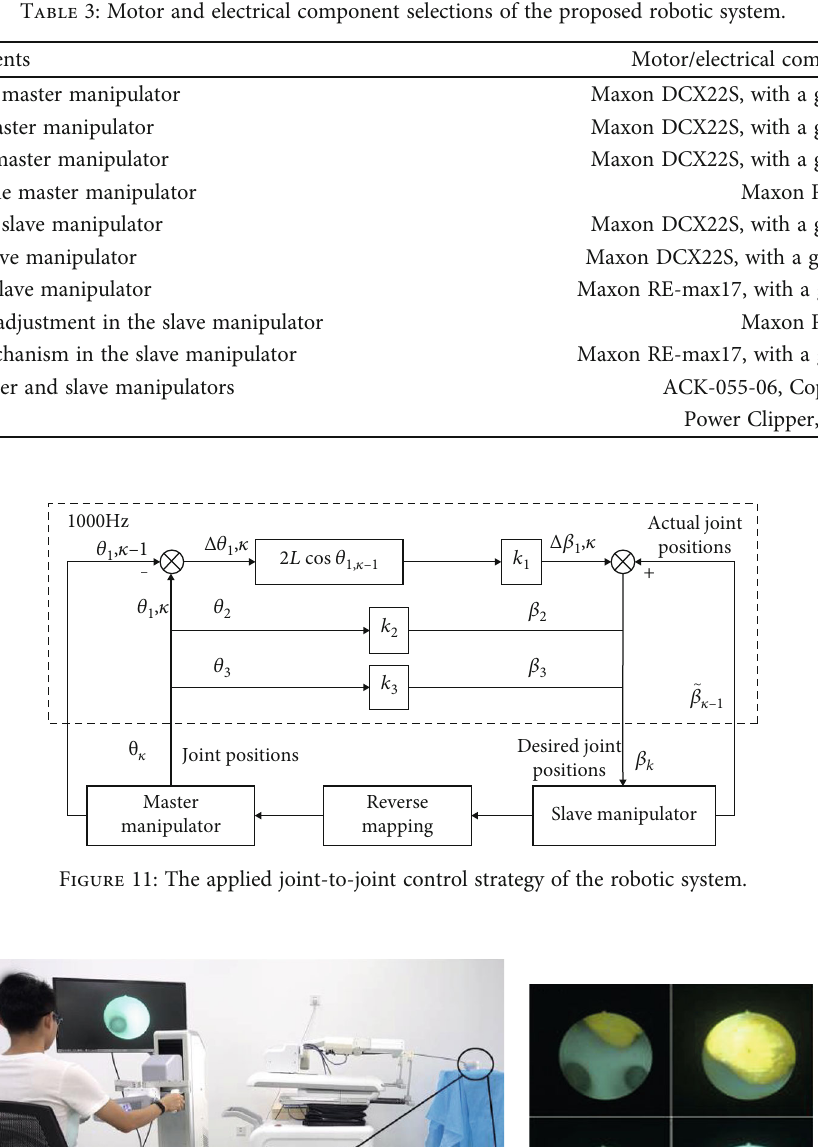
Table 3: Motor and electrical component selections of the proposed robotic system.